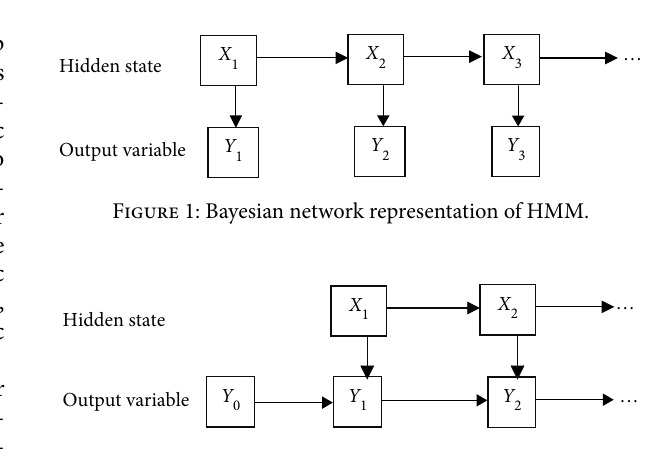
Figure 2: Bayesian network representation of